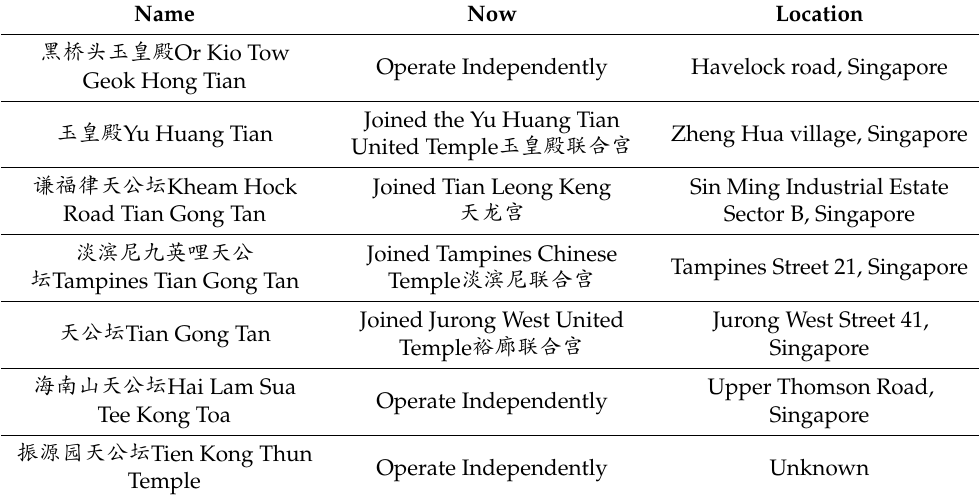
Table 8. The Jade Emperor faith